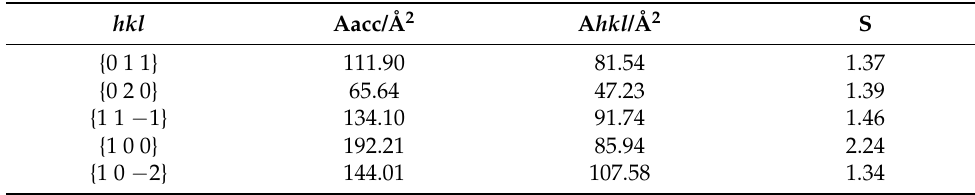
Table 3. A acc , A hkl , and corresponding S values of different β -HMX crystal